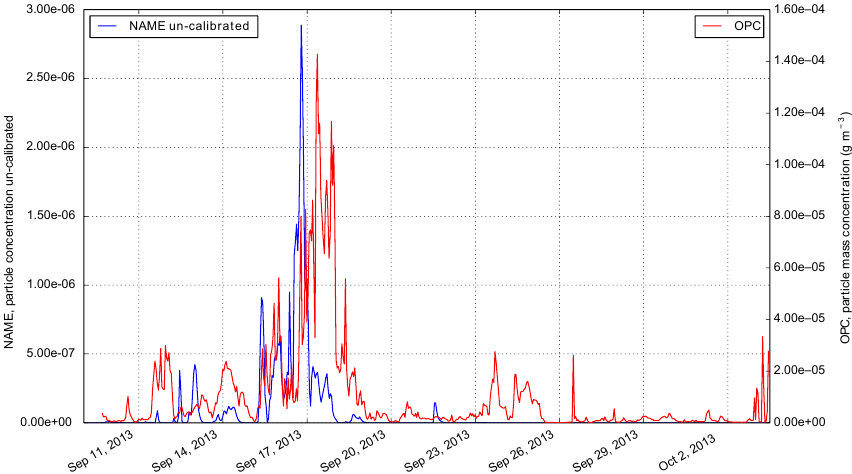
Figure 3. Time series of 1h averaged concentrations of resuspended ash derived from OPC count data (red) compared to the un-calibrated modelled air concentrations (blue) at Maríubakki during September 2013.